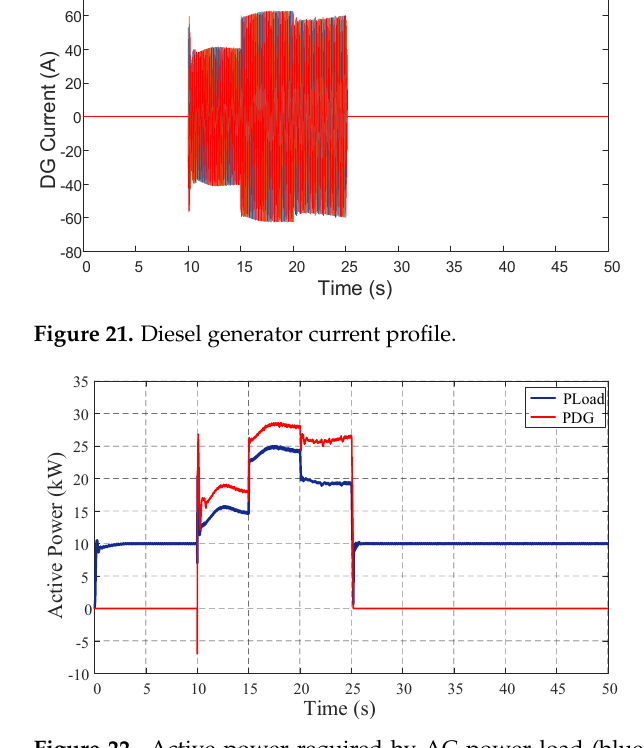
Figure 22. Active power required by AC power load (blue), and diesel generator active power output